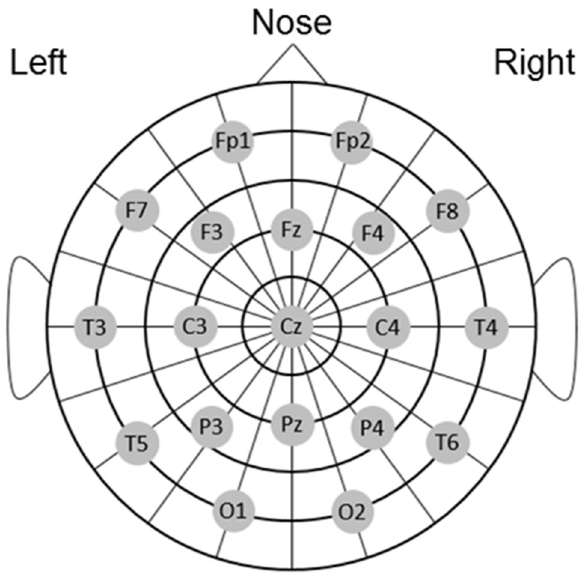
Figure 2. Electroencephalograph electrode positions (Electrode sites of the 10–20 system).